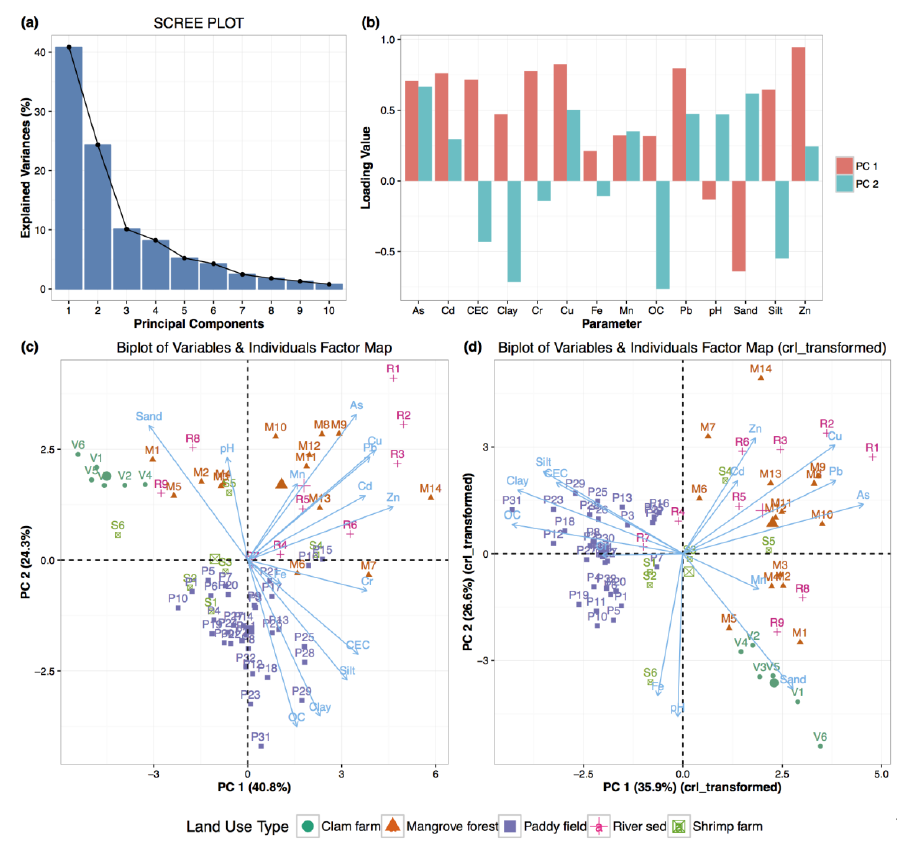
Figure 5. Results of the principal component analysis for all heavy metals and soil properties in five land uses. ( a ) Scree plot for the first 10 components of untransformed data; ( b ) Bar graph of the loading values in the first two principal components of untransformed data; ( c ) The biplot for PC1 and PC2 of untransformed data; ( d ) The biplot for PC1 and PC2 of the centered log ratio (crl) transformed data. PC, principal component.